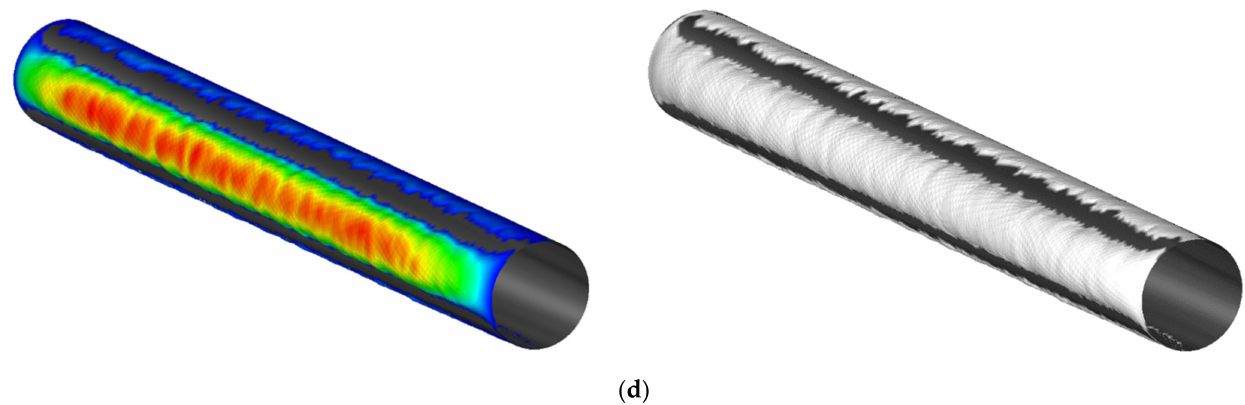
Figure 11. The bridge cable ice distributions of simulation test. ( a ) Cross-sectional view of cable ice distribution in simulation test. ( b ) Front view of cable ice distribution in simulation test. ( c ) Side view of cable ice distribution in simulation test. ( d ) The 3-D view of cable ice distribution in simulation test. The comparison between the simulation test result and the laboratory ice accretion test result that under the same conditions. Ref [22] shows that the result of the numerical simulation method conforms to reality.